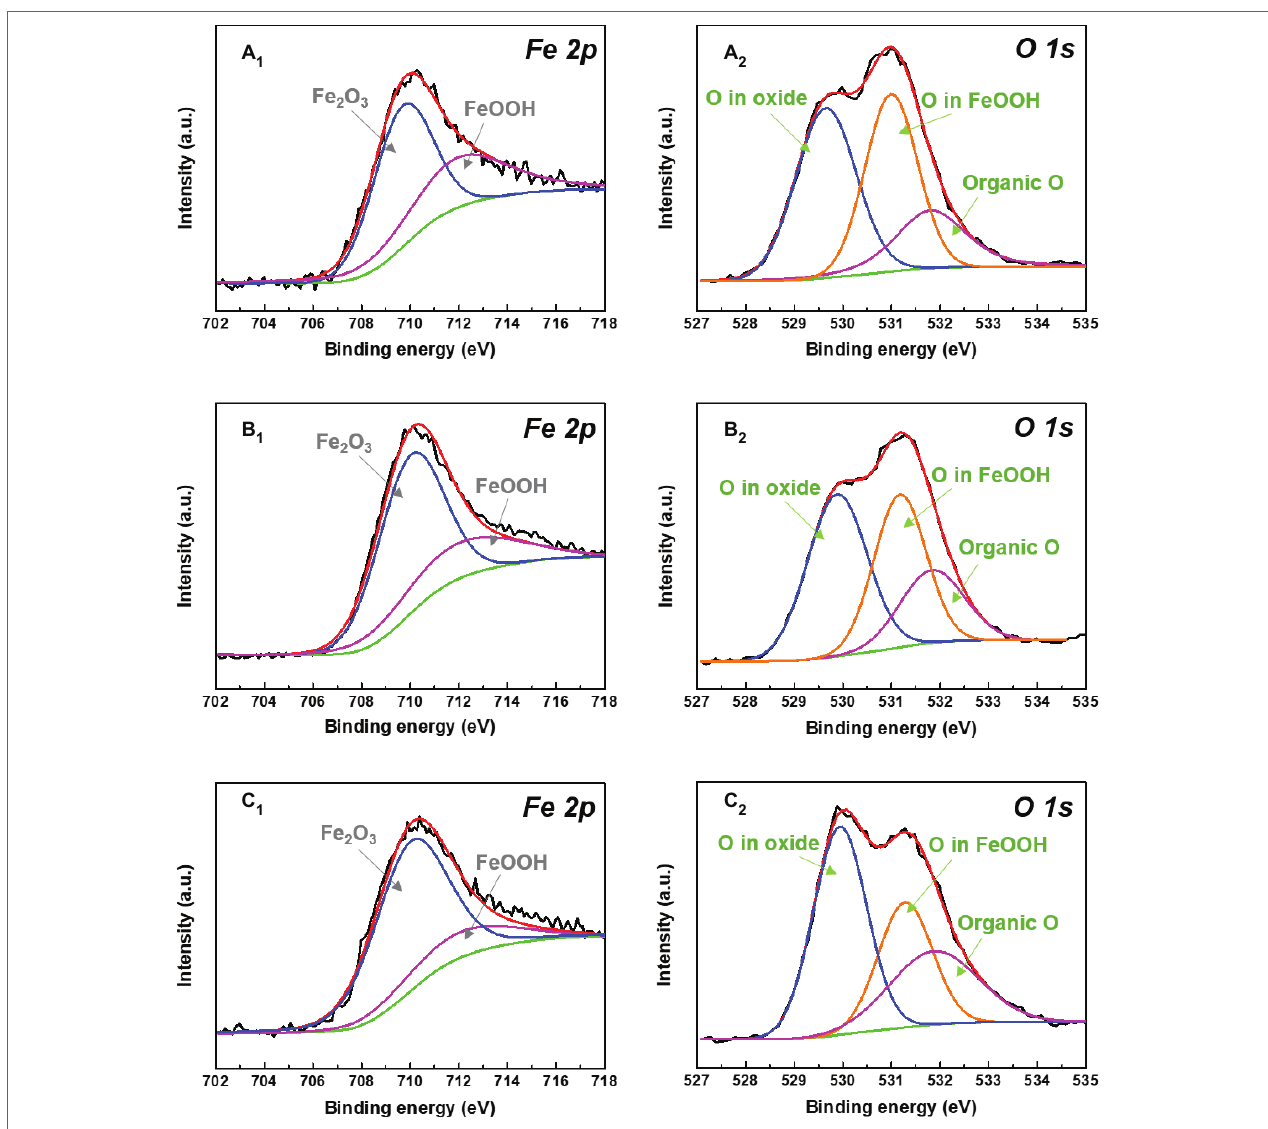
FIGURE 11 | XPS spectra of Fe 2p (A 1 –C 1 ) and O 1s (A 2 –C 2 ) of the corrosion products after 14 days of immersion in (A) 0.5 ppm, (B) 3.0 ppm, and (C) 5.0 ppm inoculated